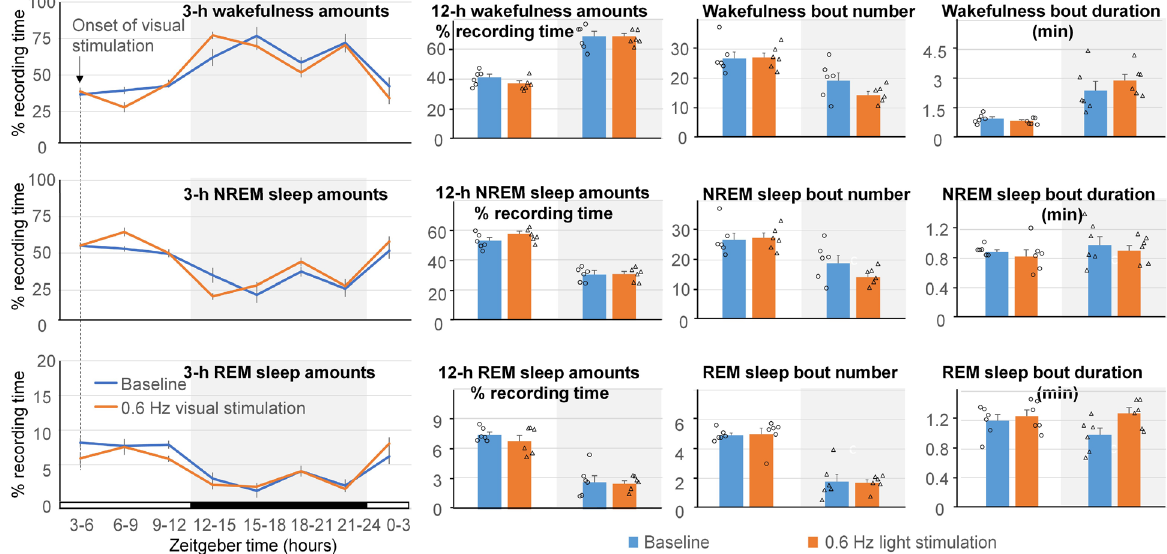
Figure 5. Effect of visual stimulation with 10-ms 620-nm light pulses at 0.6 Hz on sleep pattern. No significant differences in the amounts of wakefulness, NREM sleep and REM sleep calculated in either 3-h or 12-h intervals between the baseline and stimulation day were found. Number and duration of sleep bouts also did not change. White background indicates light periods, and grey background indicates dark